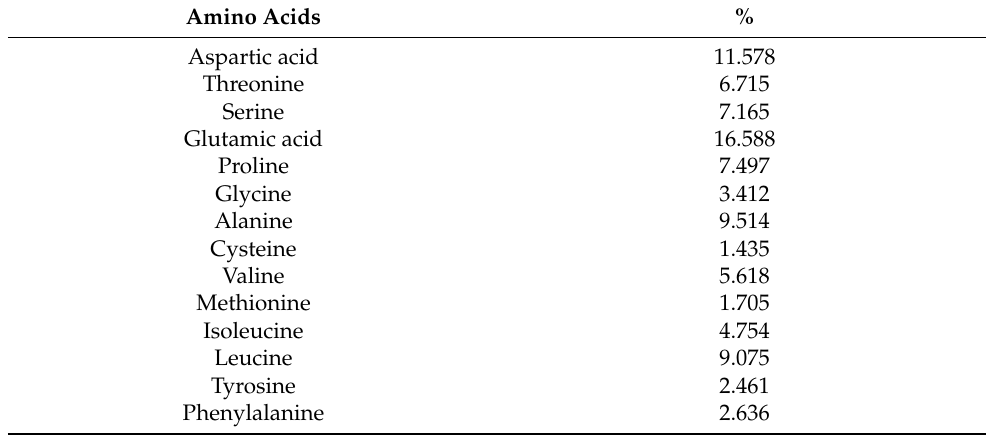
Table 1. The amino acid content (%) in